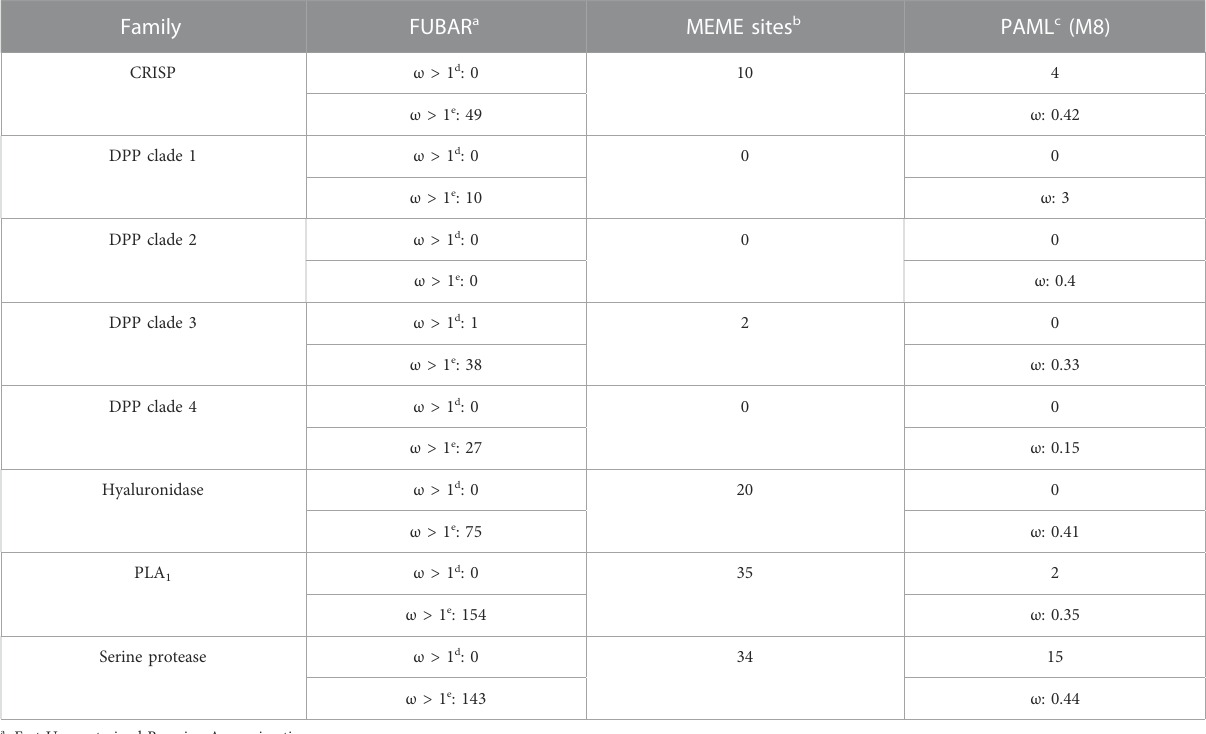
TABLE 1 The rate of molecular evolution of various vespid toxins.